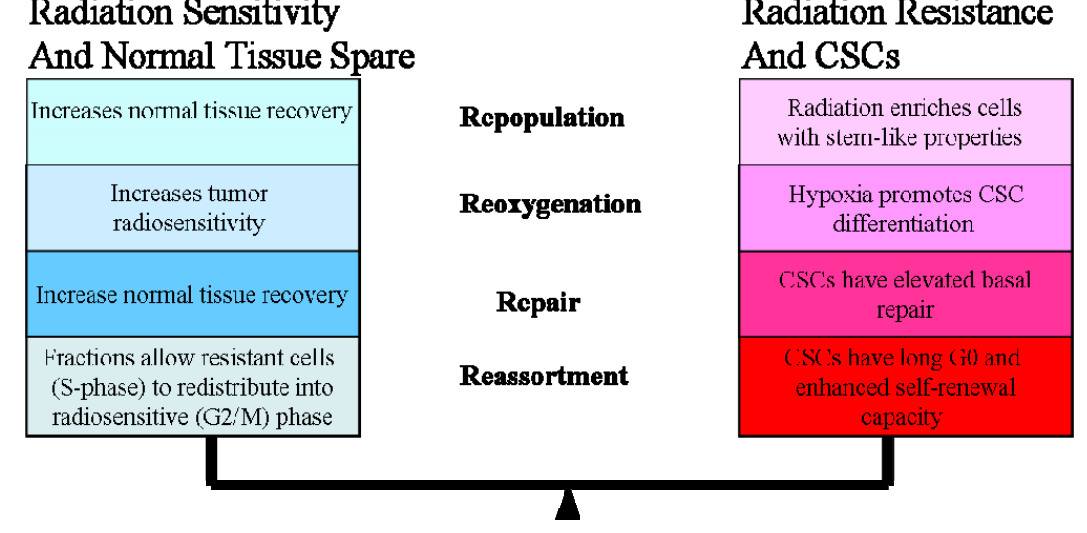
Figure 1. The potential complications of cancer stem cells for fractionated